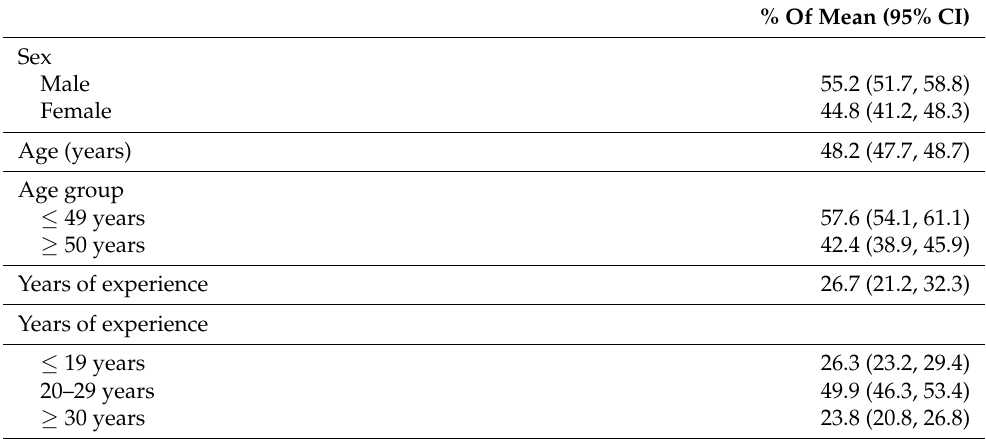
Table 1. Participant